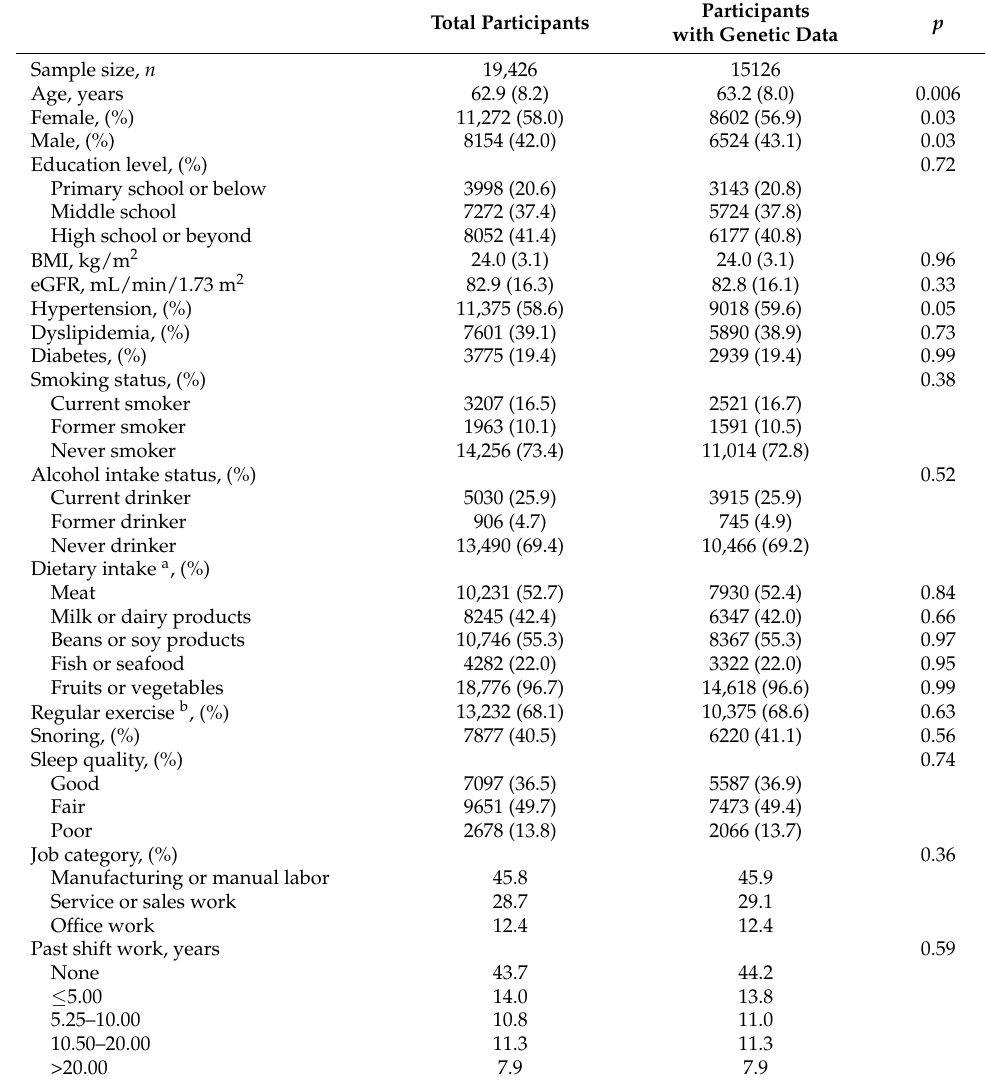
Table 2. Baseline characteristics of the total participants and participants (N = 19,426) with genetic data (N = 15,126).